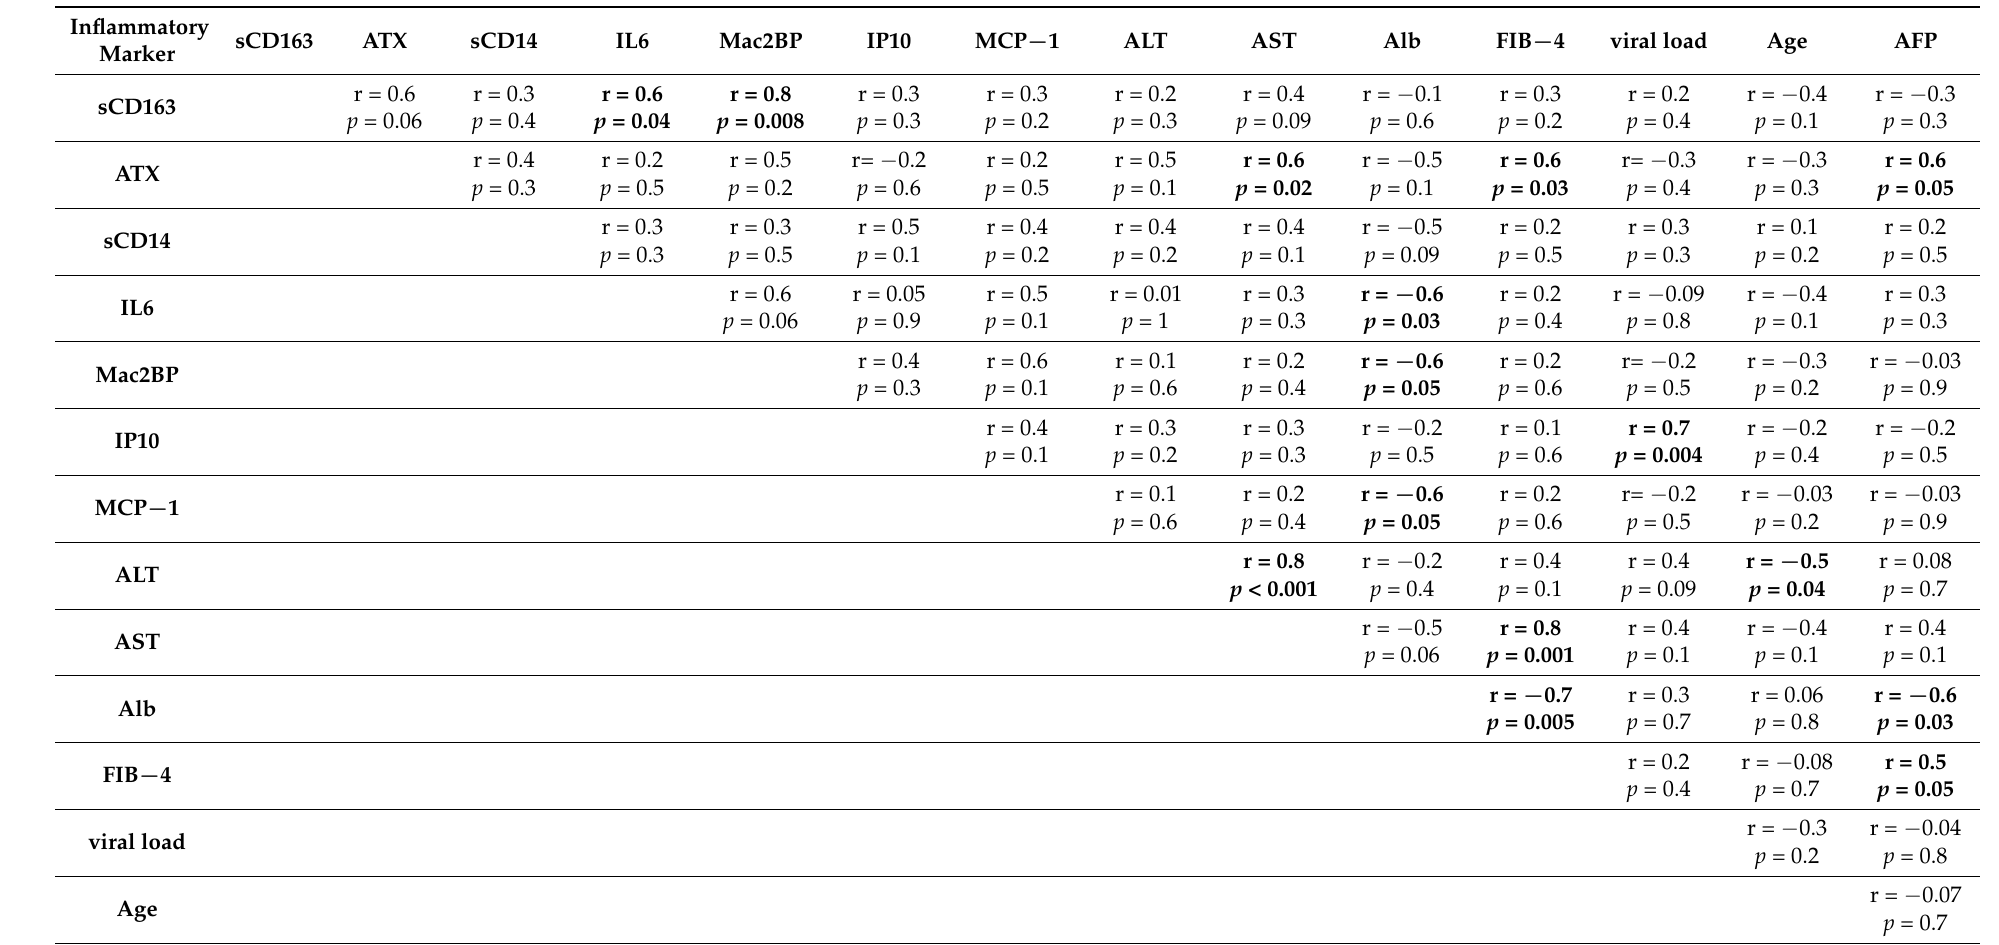
Table 3. Correlations between biomarkers At the Start of